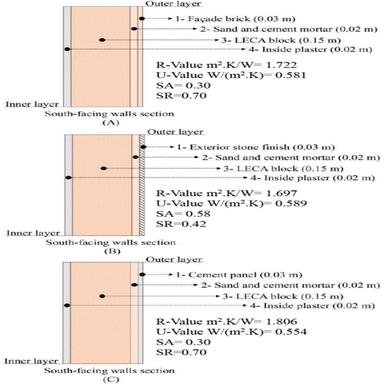
Types of south-facing walls and thermal properties: A) brick, B) stone, and C) cement.